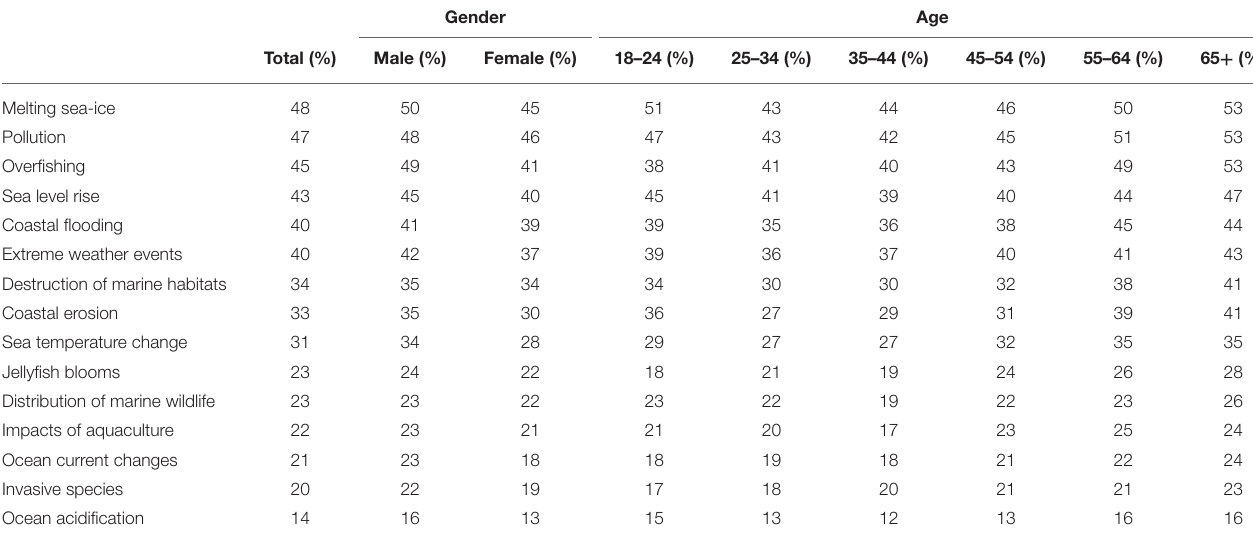
TABLE 2 | Self-declared level of “informedness” among the different demographic groups surveyed, regarding impacts of marine climate